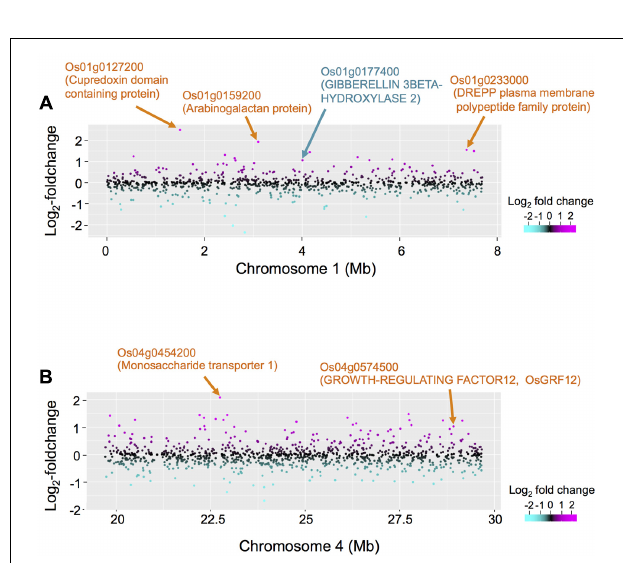
FIGURE 5 | Comparison between differentially expressed genes (DEGs) and eQTL hotspots on chromosomes 1 and 4. (A) The differential expressions in non-deepwater- and deepwater-type RILs are plotted on the region of eQTL hotspots on chromosome 1 (genome position: 0–7.72 Mb) in log 2 -foldchanges. The red horizontal line indicates LOD = 3. (B) The differential expressions in non-deepwater- and deepwater-type RILs are plotted on the region of eQTL hotspots on chromosome 4 (genome position: 19.7–29.7 Mb) along the physical genome position in log 2 -foldchange. The red horizontal line indicates LOD =